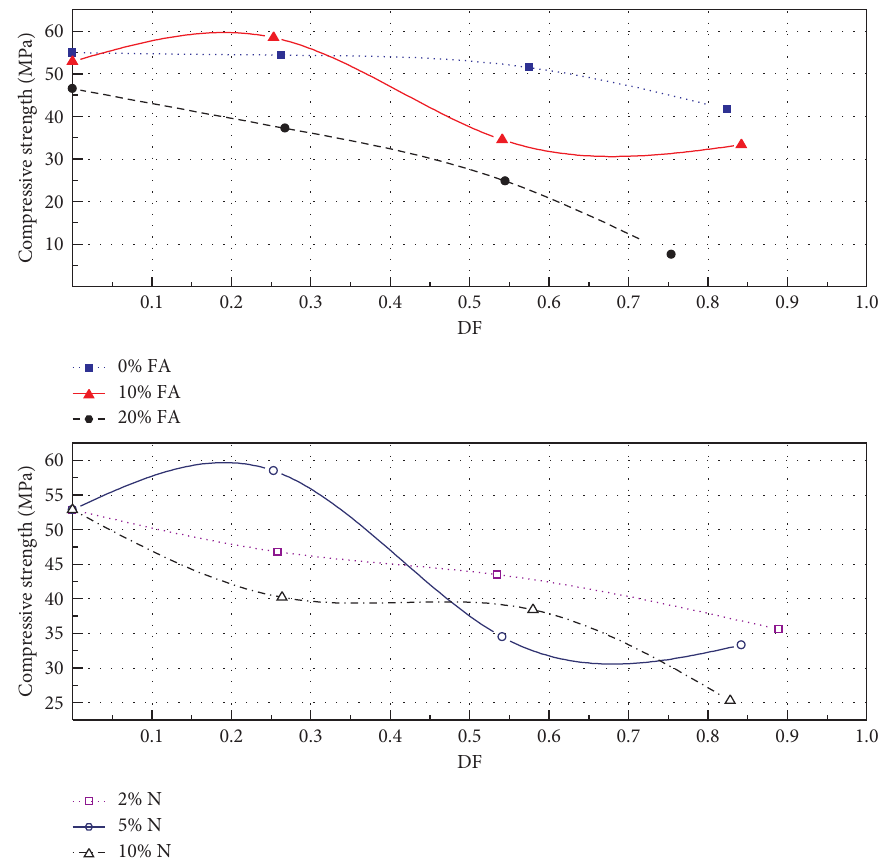
Figure 17: DF versus compressive strength before and after the coupling cycles.